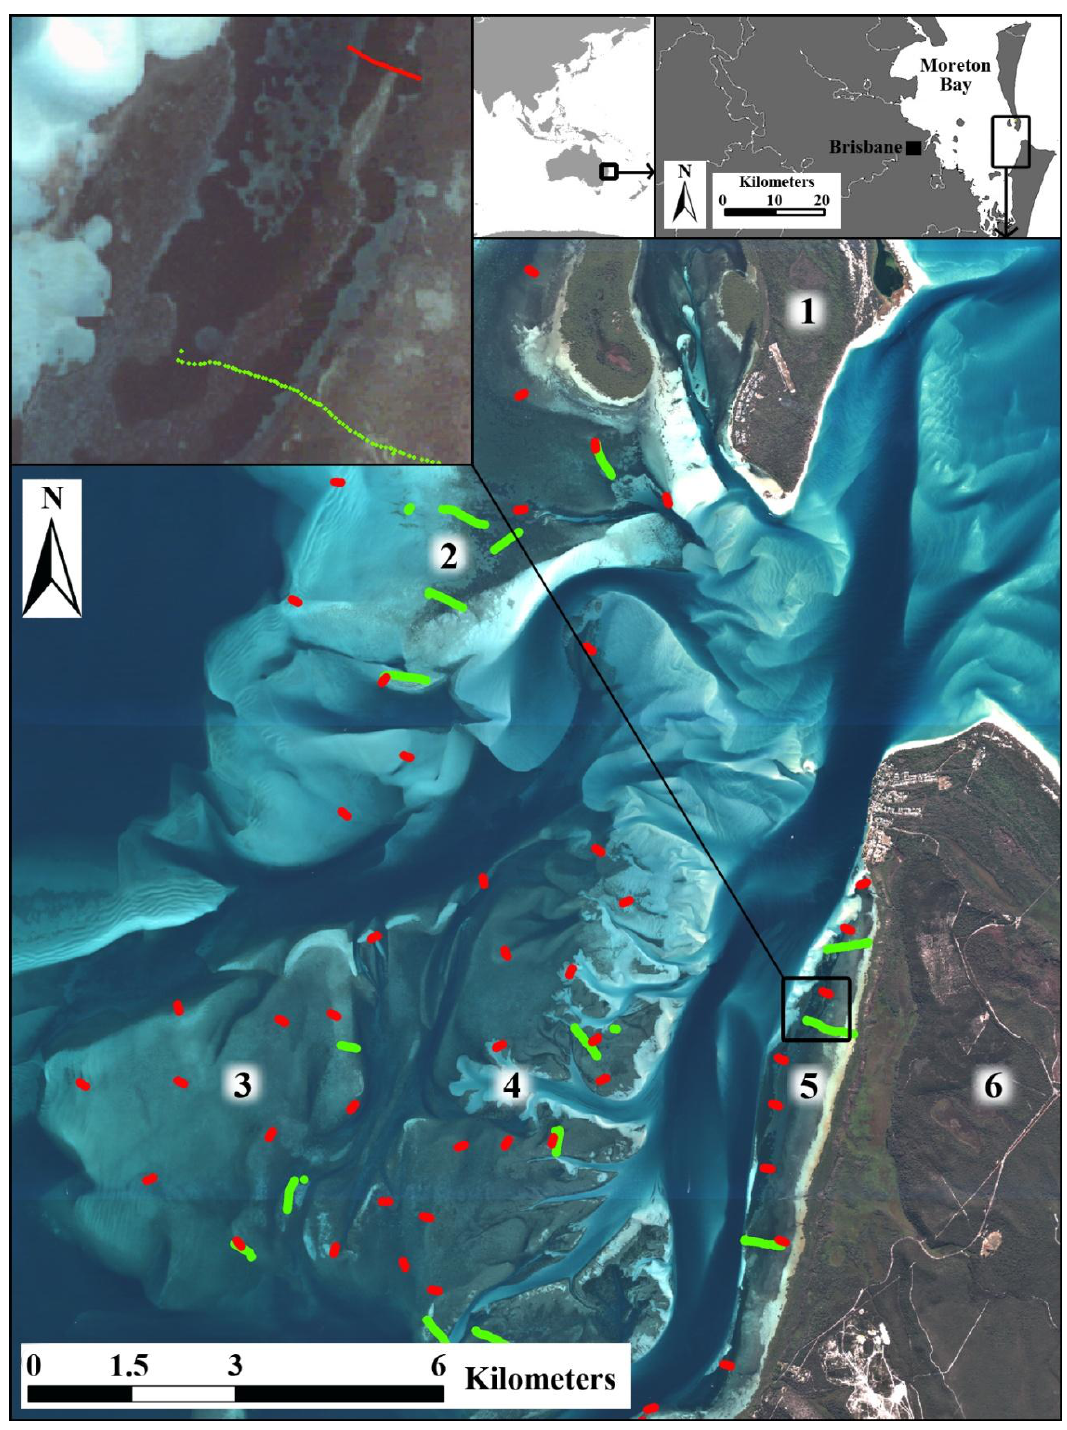
Figure 1. The Eastern Banks, Moreton Bay and a 1 km × 1 km area zoomed on the Wanga Wallen Banks (inset). The 2004 (red) and 2007 (green) seagrass field survey data is overlayed. 6 major areas are labelled; (1) Moreton Island, (2) Moreton Banks, (3) Maroom Banks, (4) Amity Banks, (5) Wanga Wallen Banks, (6) N th Stradbroke Island. Image data–Quickbird, true colour, BGR bands, 2.4 m pixels, 4 July 2007) (Image source and copyright: